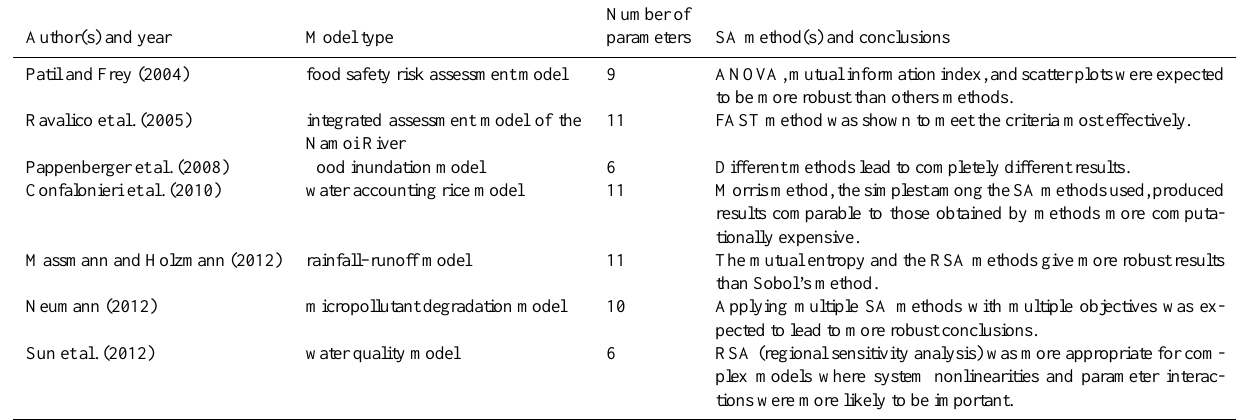
Table 1. Comparison of different SA